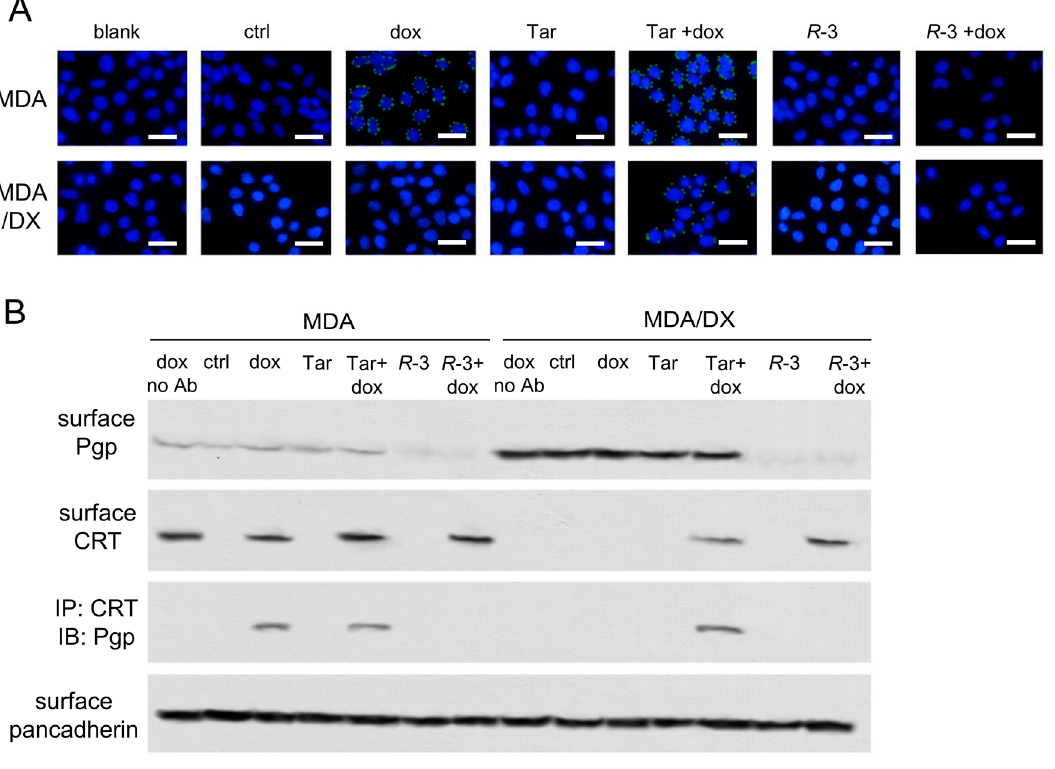
Figure 4. R -3 disrupts Pgp-calreticulin interaction, favoring the internalization and ubiquitination of Pgp. Human triple-negative breast cancer MDA-MB-231 cells and their doxorubicin (DX)-resistant variant were incubated for 24 h in fresh medium (ctrl) or in medium containing 5 μ M doxorubicin (dox). When indicated, 75 nM Tariquidar (Tar) or 75 nM R -3 were added. ( a ) Proximity ligation assay between Pgp and calreticulin. Blank: cells incubated without primary antibodies. Blue signal: nuclear staining (DAPI). Green signal: Pgp/calreticulin interaction. The image is representative of 1 out of 3 experiments. A minimum of 5 fields/experiment was examined. Bar: 10 μ m (10× ocular lens; 63× objective lens). ( b ) Plasma membrane extracts were immunoblotted and decorated to detect Pgp or CRT, or immuno-precipitated (IP) with an anti-CRT antibody, then immunoblotted (IB) with an anti- Pgp antibody. no Ab: MDA-MB-231 and MDA-MB-231/DX samples treated with doxorubicin, immuno-precipitated without antibodies. An aliquot of the extracts before the immunoprecipitation was probed with an anti-pancadherin antibody, as control of equal protein loading. The figure is representative of 1 out of 3 experiments. ( c ) MDA-MB-231/DX cells were incubated 24 h with 75 nM